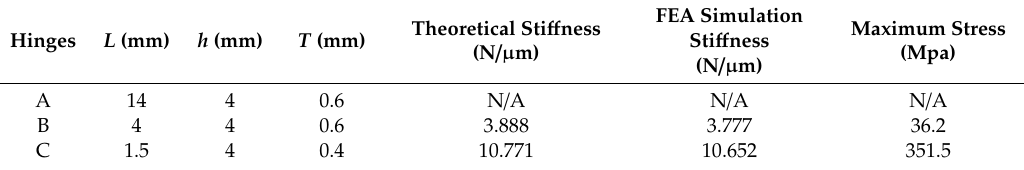
Figure 5. First order natural frequency of the stage base. Table 2. Characteristic parameters of the A, B, C hinges. FEA = finite element